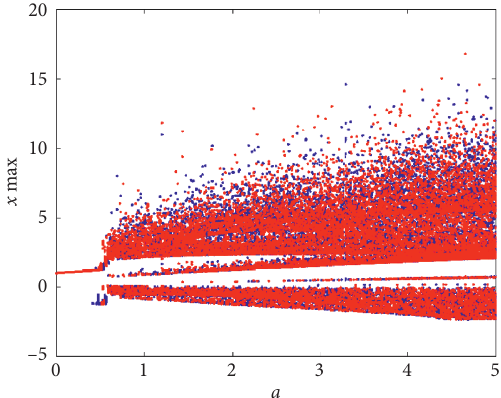
Figure 23: Bifurcation diagram versus the parameter a at ( 0 . 2 , 0 . 2 , 0 . 2 ) and ( 0 . 2 , 0 . 5 , 0 . 2 ) .